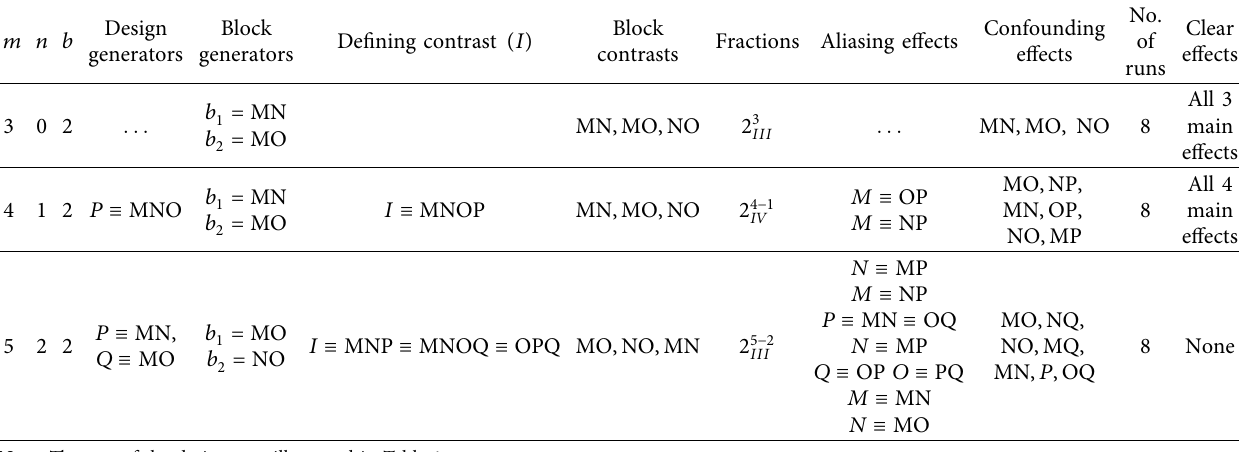
Table 1: Eight-run design and block generators for m � 3, 4, and 5 with 4 choices set of size 2. m n